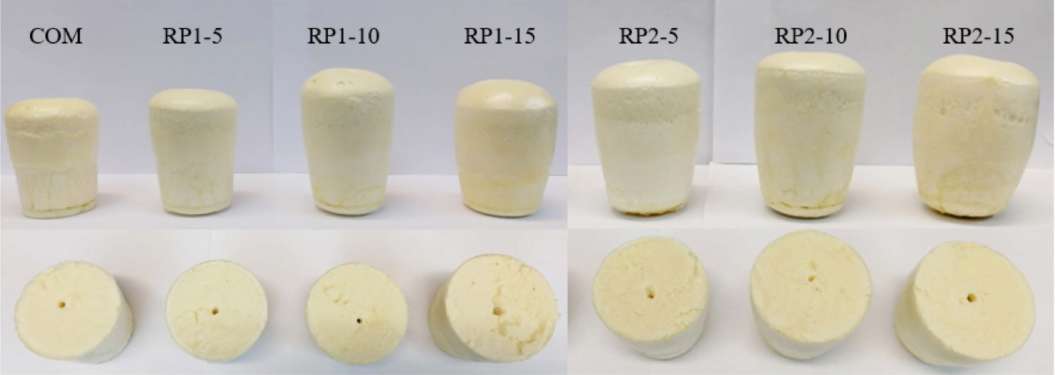
Figure 5. Physical appearance and internal structure of RPUFs synthesized with